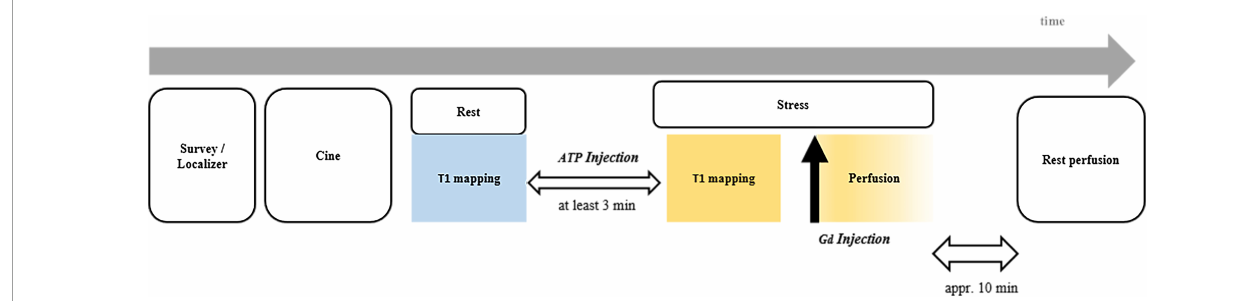
FIGURE1 Timeline for CMR scan protocol. CMR, cardiac magnetic resonance.